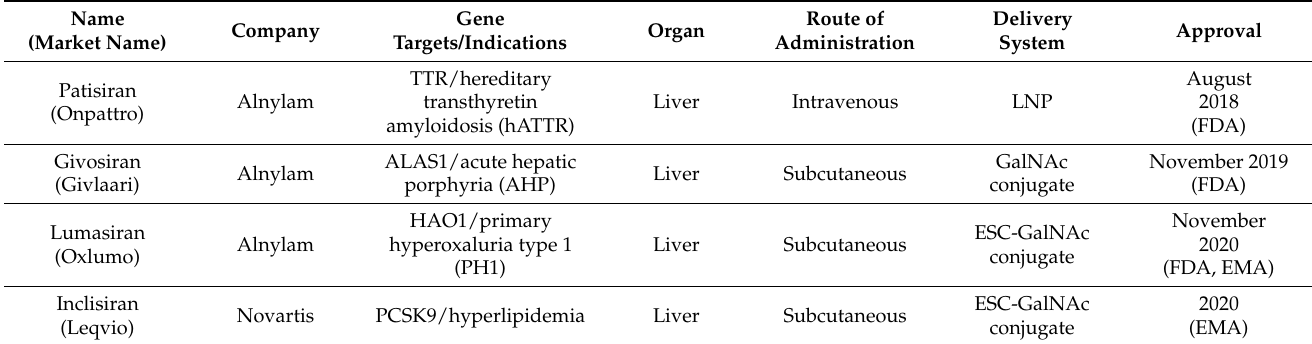
Table 1. Currently approved siRNA therapeutics for non-cancerous